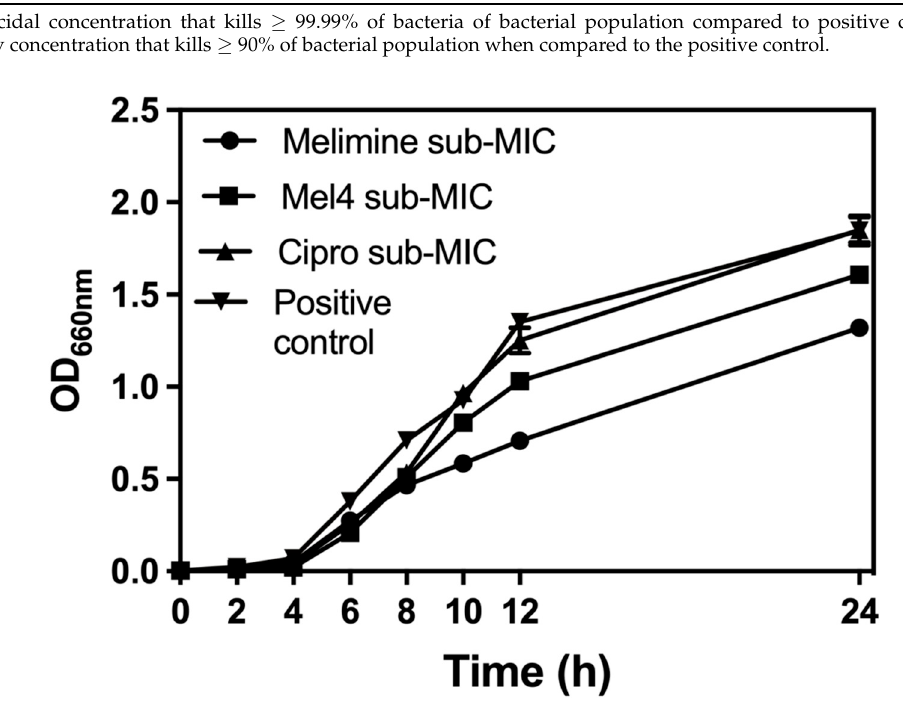
Figure 1. Growth curves for S. aureus ATCC 25923 at sub-MIC of the antimicrobial peptides (AMPs) melimine and Mel4 or ciprofloxacin (Cipro). Melimine and Mel4 reduced the overall bacterial growth over 24 h of experiments while ciprofloxacin and the positive control (without any antimicrobial) had similar growth characteristics after 24 h experiment.